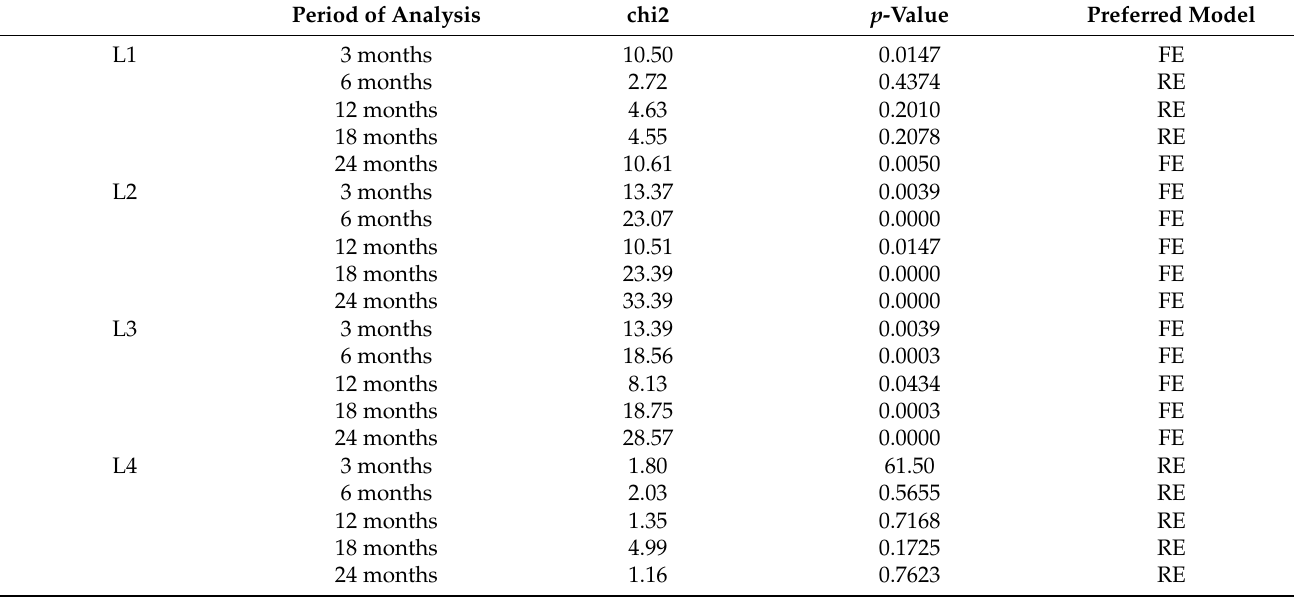
Table 3. Hausman test results for the Romanian sample.